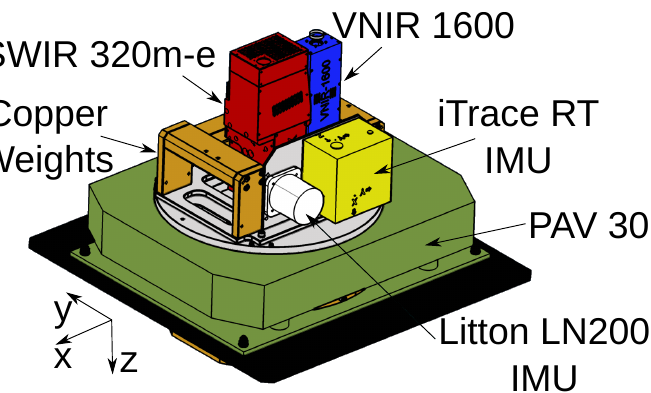
Figure 2: Experimental setup of the HySpex sensor system. x is the flight direction and z is nadir. The experimental setup of the HySpex sensor system is shown in figure 2. Both sensors are mounted facing nadir on the Leica PAV30 gyro stabilized camera mount. The iMAR IMU used for georeferencing and the Litton LN-200 IMU aiding PAV30 operation are both rigidly attached to the sensor assembly. The HySpex Data acquisition unit is installed in a DLR F20 rack (not shown) along with an Applanix